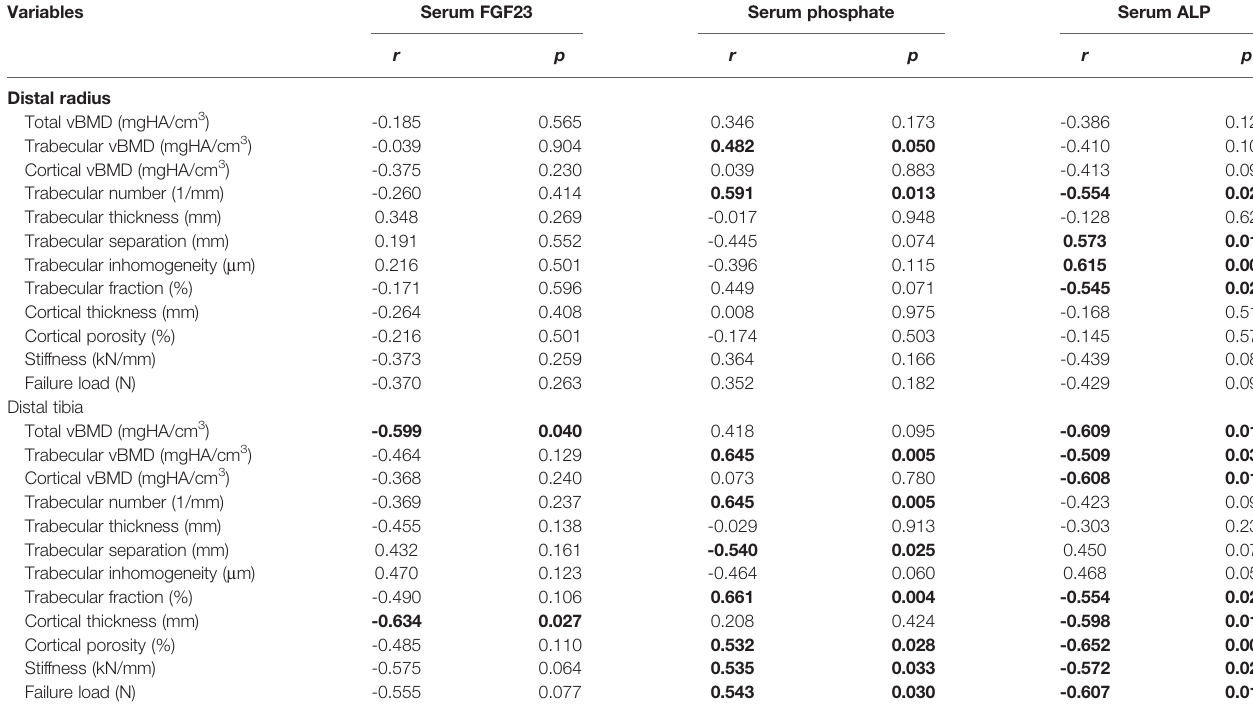
HR-pQCT, high-resolution peripheral quantitative computed tomography; FGF23, fi broblast growth factor 23; ALP, alkaline phosphatase; HA, hydroxyapatite; vBMD, volumetric bone mineral density. Bold values indicate p value <